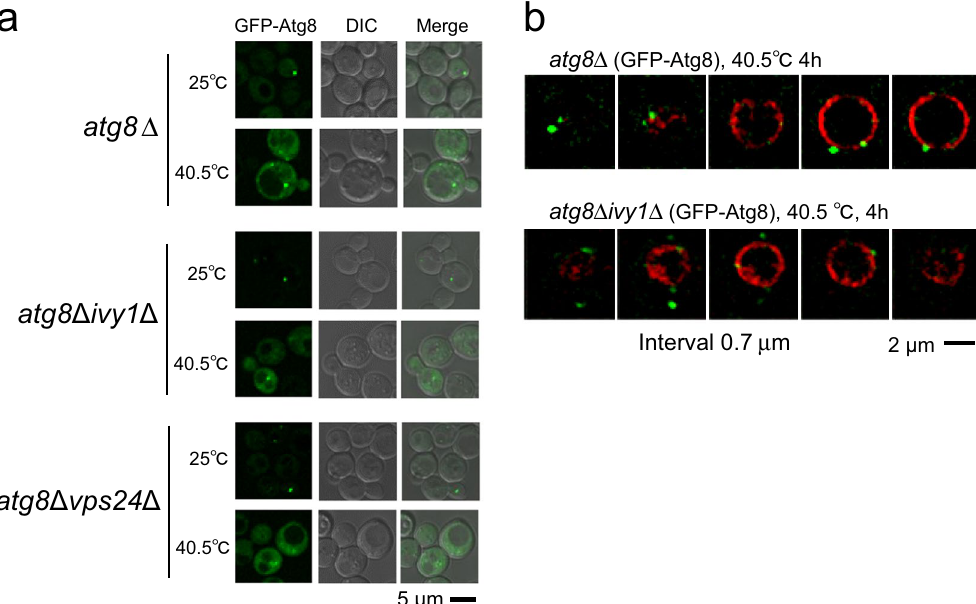
Figure 6. Localisation of GFP-Atg8. ( a ) Localisation of GFP-Atg8 in cells incubated at 25 °C and at 40.5 °C for 4 h: a plasmid expressing GFP-Atg8 under the control of ATG8 promoter was expressed in atg8 Δ , atg8 Δ ivy1 Δ , and atg8 Δ vps24 Δ cells. ( b ) Z-stack analysis of GFP-Atg8 dots observed in control, atg8 Δ , and atg8 Δ ivy1 Δ cells at 40.5 °C for 4 h. Merged images of GFP and FM4-64 fluorescence are shown. The images were taken by SCLIM, and images at 0.7 μ m intervals are shown. Scale bar, 2 μ